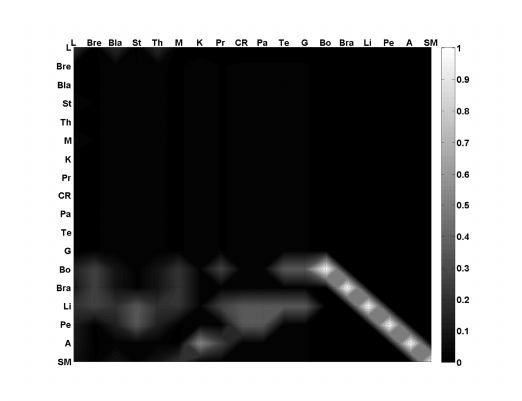
Fig. 5: Visualization of the transition matrix, in gray scale, for tertiary